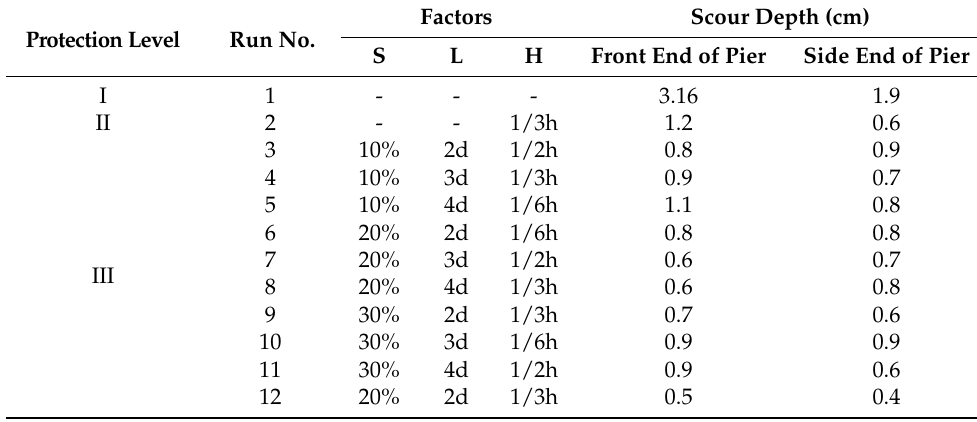
Table 2. Experimental design and the experimental